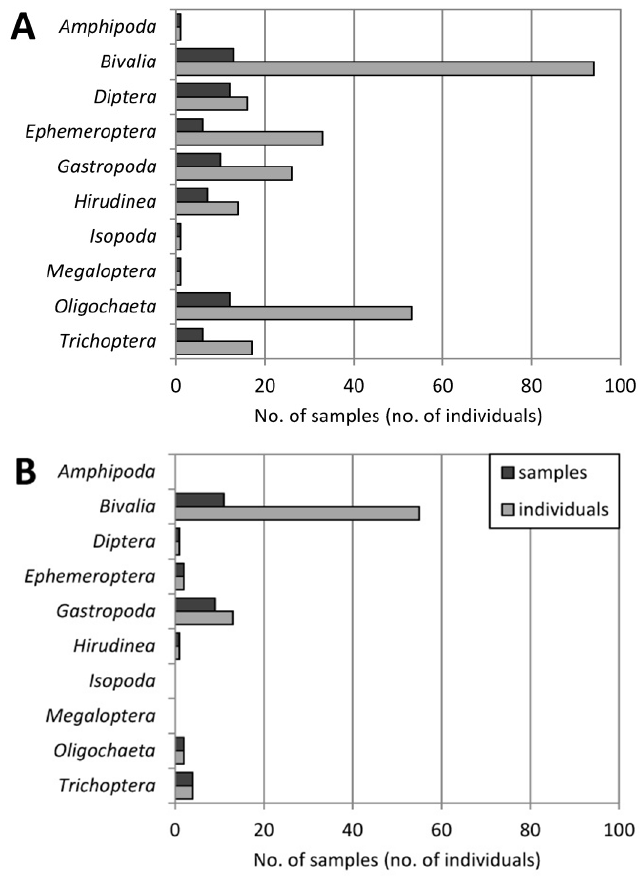
Figure 2. Comparison of the abundance of macroinvertebrate taxa vs. number of